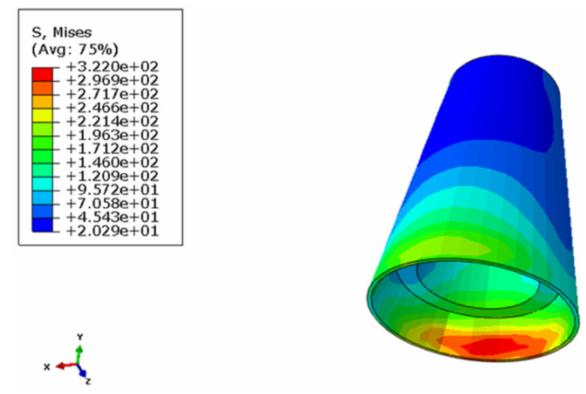
Figure 6. Stress distribution in the